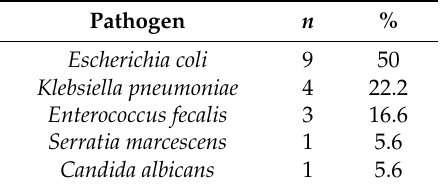
Table 1. Numbers and percentages of isolated microorganisms.